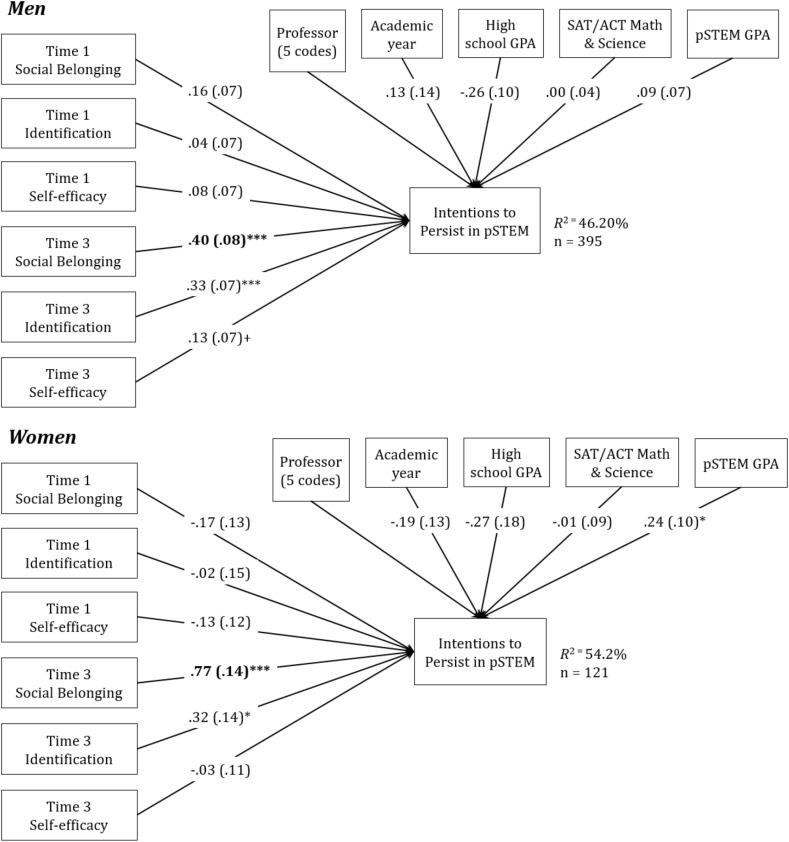
Path models depicting relationships among social belonging and intentions to persist for men and women, controlling for professor, academic year, and prior and ongoing performance. Unstandardized betas are presented, with Standard Errors in parentheses. Paths in bold were significantly different for women and men. For simplicity, paths for professor are not.